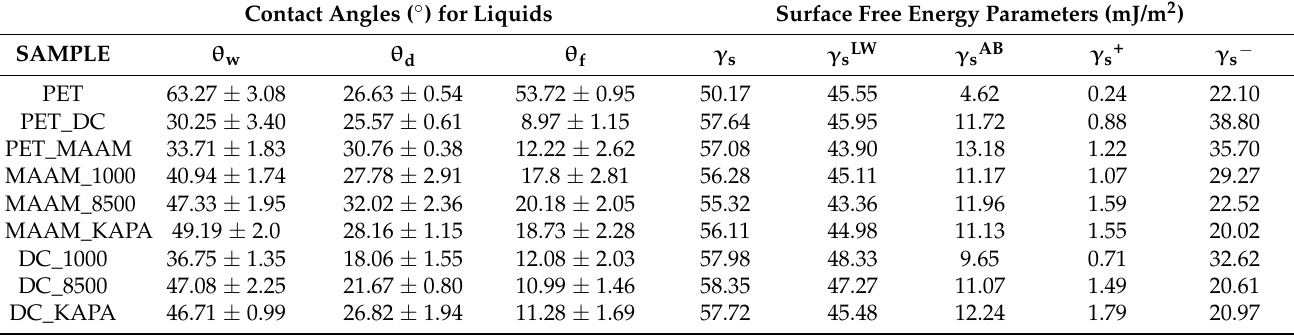
Table 1. Contact angles ( θ ) (w: deionized water; d: diiodomethane; f: formamide) and surface free energy parameters of probe liquids used in the acid-base method ( γ g total surface fee energy, apolar γ sLW, polar γ sAB, Lewis acid γ s+ and base γ s- components). PET is the virgin